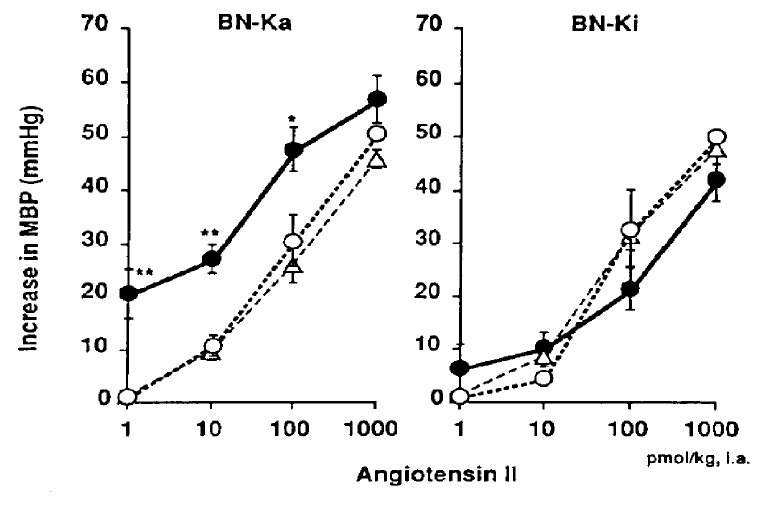
intra-arterial injection of angiotensin II to conscious kininogen-deficient Brown Norway-Katholiek (BN-Ka) rats and conscious normal Brown Norway-Kitasato (BN-Ki) rats during infusion of two doses of NaCl. Values show the means ±S.E.M. from six rats. Sodium chloride solution (0.3 M or 0.15 M) was infused (6 mL/kg/hr) into the abdominal aorta for four days from 10 weeks of age. Values from rats infused with 0.3 M sodium chloride solution (closed circles) were compared with those infused with 0.15 M sodium chloride solution (open circles) at the same dose. *P < 0.05, **P < 0.01. Values represented by open triangles are those from untreated rats (quoted with permission from Ref.